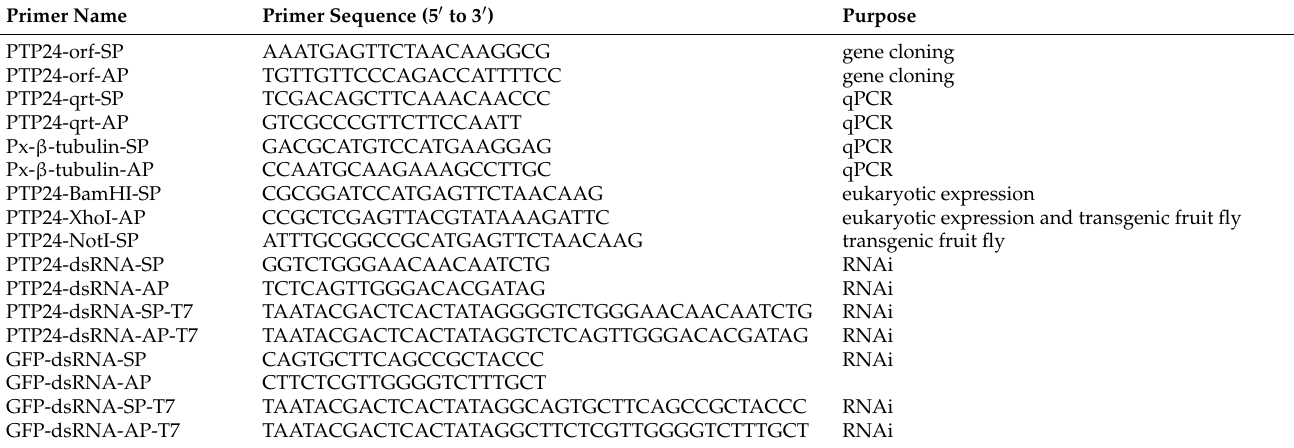
Table 1. The primer sequences for functional studies of